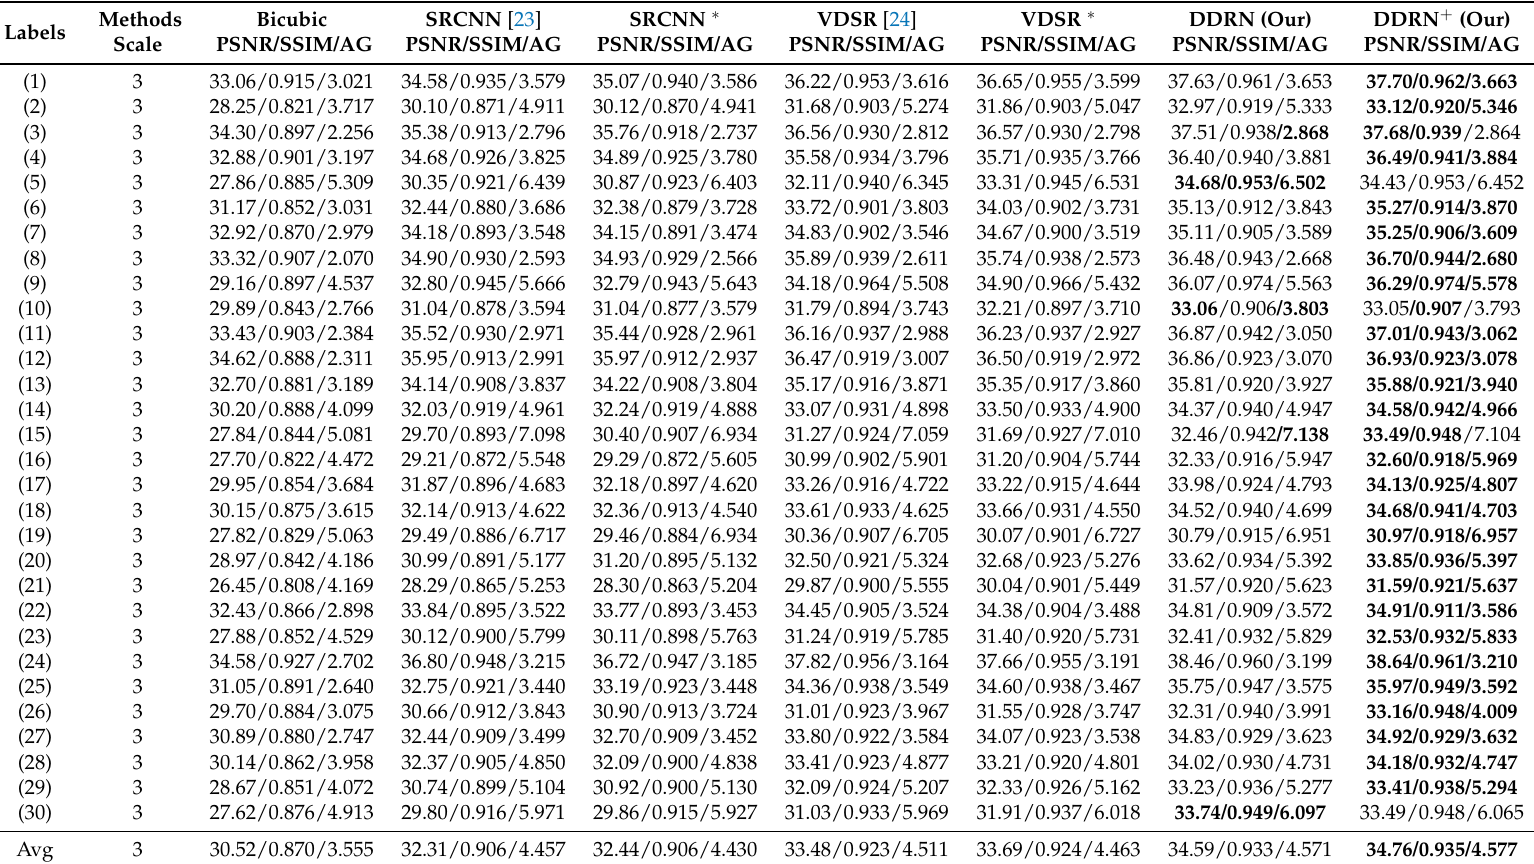
Table 2. Quantitative evaluation of the proposed DDRN approach and its improved version DDRN + against some state-of-the-art SISR algorithms on Kaggle Open Source Dataset with 30 different scenarios for the scale factor of × 3. Bold indicates the best performance. Particularly, ∗ refers to the modules retrained by us with Kaggle Open Source Dataset